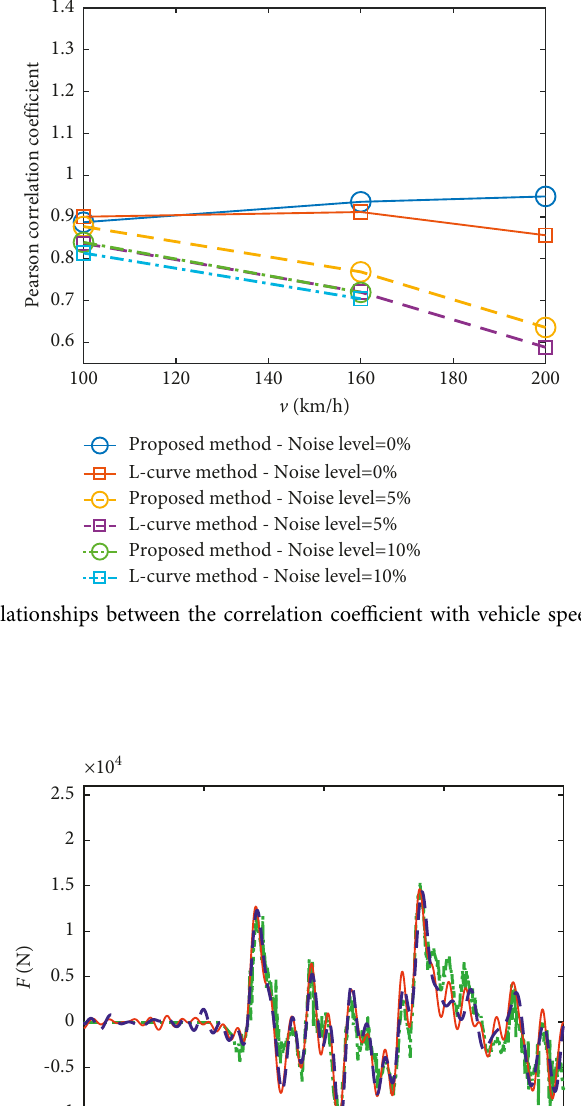
2 identification when the noise level is